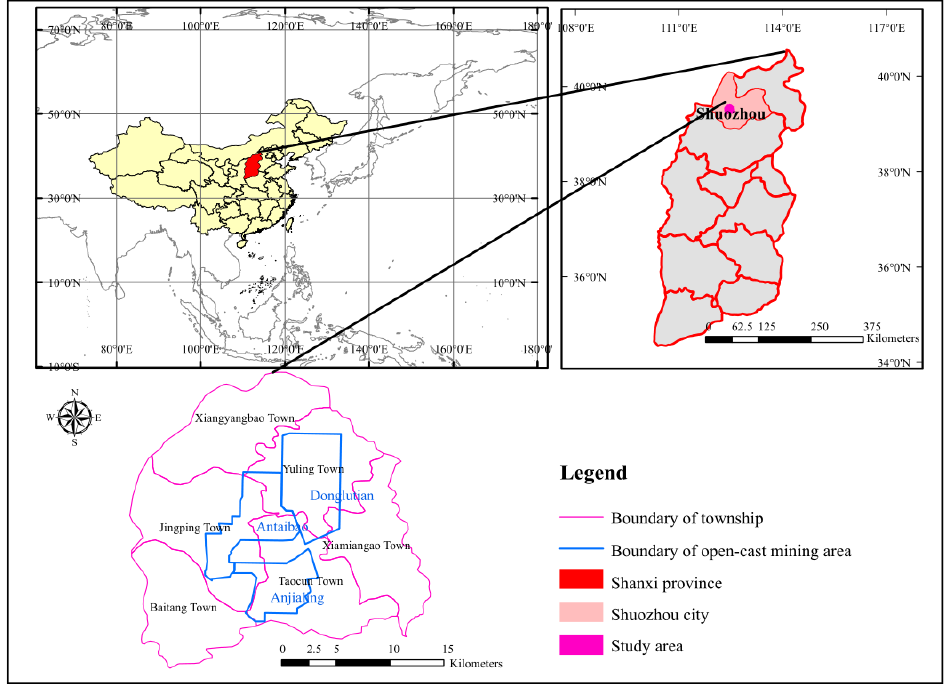
Figure 1. Location of the study area.